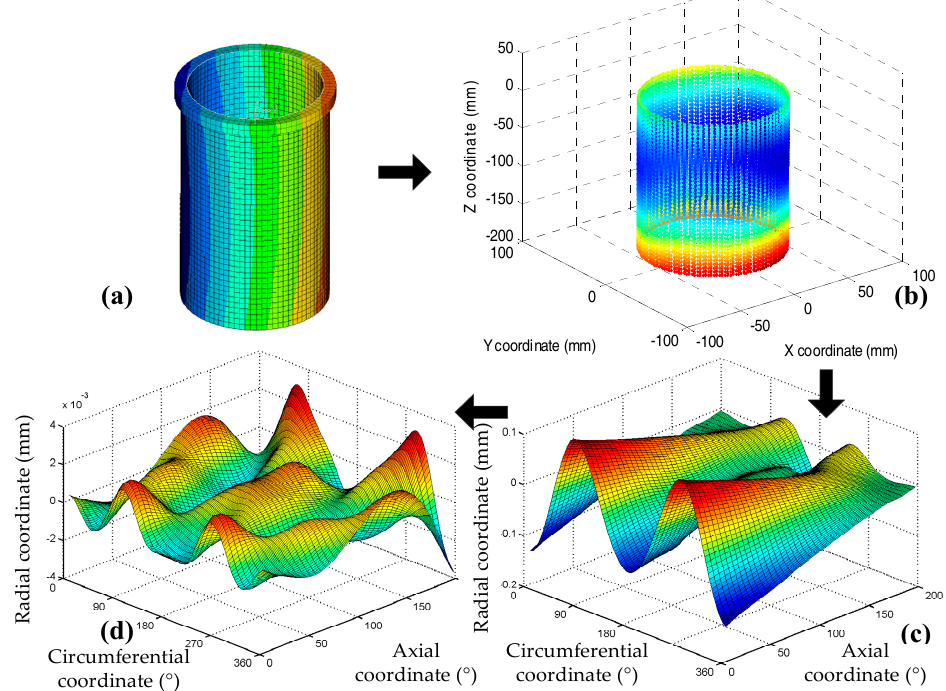
Figure 6. Flowchart of the geometric extraction and coordinate transformation. ( a ) Simulated deformation of cylinder liner in ANSYS; ( b ) Deformation of liner inner surface in MATLAB; ( c ) Liner deformation in two-dimensional coordinates; ( d ) Liner deformation excluding the overall displacement.